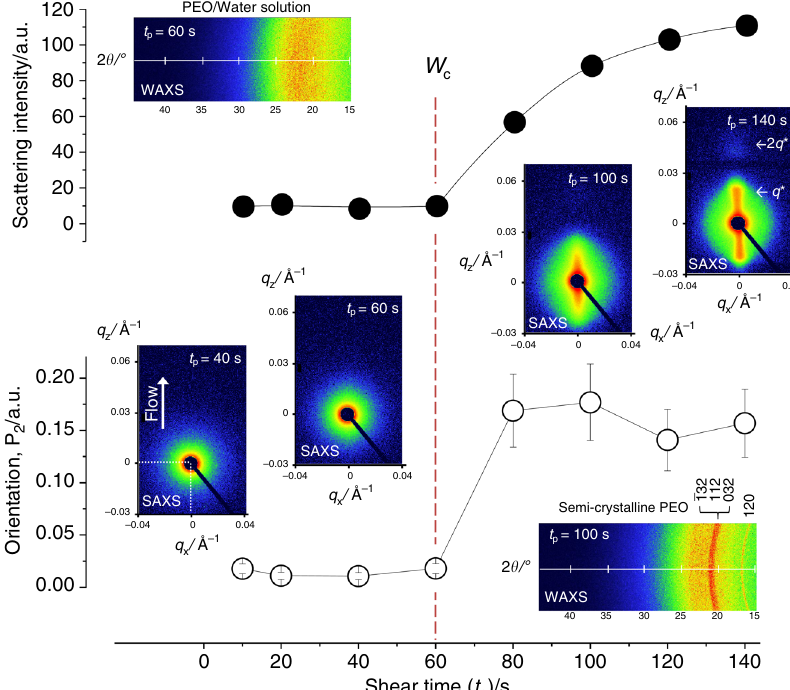
Fig. 4 In situ rheo-SAXS/WAXS measurements of PEO crystallisation. Characterisation of fl ow-induced nucleation of 60% w/w PEO aqueous solution by in situ rheo-SAXS/WAXS technique. The images are 2D scattering patterns recorded after shearing the solution at _ γ = 10 s − 1 for various times at 25 °C. The fl ow direction is shown on the SAXS pattern of t p = 40 s. The upper and lower graphs show the dependence on shearing time of the total intensity of SAXS patterns and Hermans ’ s P 2 orientation function (the anisotropy calculated from 2D SAXS patterns), respectively. The red dashed line indicates the shearing time required for PEO nucleation under the chosen shear rate which was calculated from W c measured by SIPLI. Miller indexes assigned to WAXS pattern corresponding to t p = 100 s indicate positions of diffraction peaks associated with 7 2 helical PEO crystal structure (space group P2 1 /a). q * and 2 q * shown in the SAXS pattern corresponding to t p = 140 s indicate peak positions associated with the fi rst and second order of lamellar morphology with the period of ~ 140 Å formed by oriented semi-crystalline PEO. Error bars indicate uncertainty associated with P 2